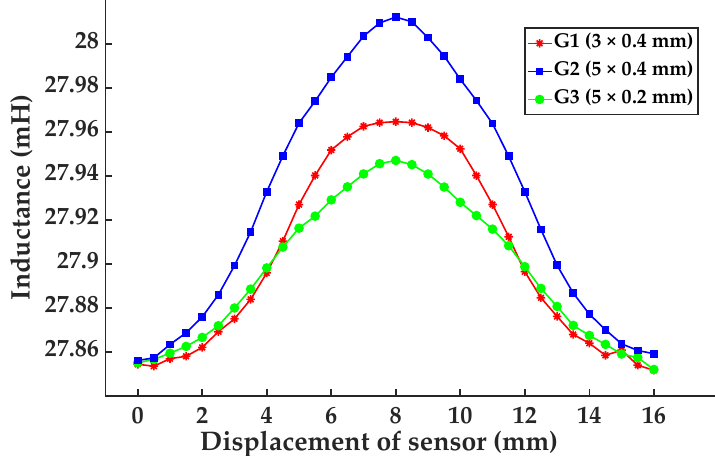
Table 2. Groove parameters in the X-direction (Starting from X = 0). Figure 4. Sensors scan the inductance of grooves with different parameters. Figure 4. Sensors scan the inductance of grooves with different parameters.